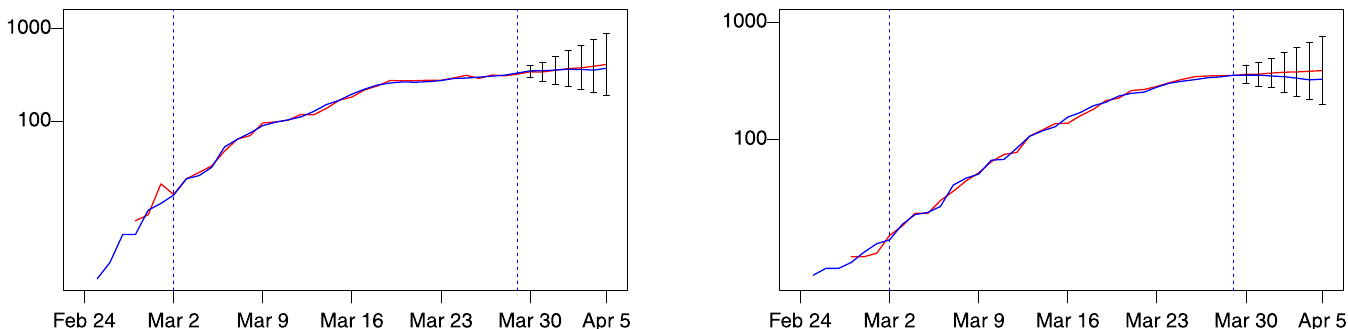
Fig 7. Emilia Romagna (model d (1, 1)) and Veneto (model d (2, 1)). Blue: actual; red: fitted (in estimation sample) or forecast (out-of-sample). Left: number of patients admitted in ICU in Emilia Romagna. Right: number of patients admitted in ICU in Veneto. Training sample: February 28–March 29. Out-of-sample period: March 30– April 5. Forecast intervals ± 3 standard